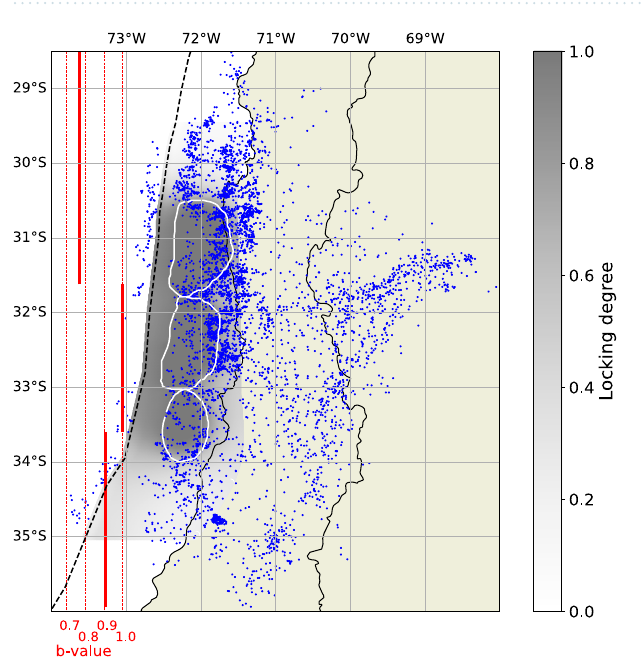
Figure 5. The figures show the Gutenberg–Richter law representation of the obtained b-value for each segment. Upper figures represent the solutions along strike, and lower figures correspond to the results along dip. The blue star represents the number of events larger than a magnitude m , the orange line corresponds to the Gutenberg Richter law computed with the obtained b-value, and the red dotted line represents the chosen M c . ( a ), ( b ) and ( c ) correspond to the events from 0 to ∼ 33 km, from ∼ 33 to ∼ 70 km, and from ∼ 70 to ∼ 160 km depth, respectively. Subfigures ( d ), ( e ), and ( f ) correspond to the events between 35.94 ◦ to 33.59 ◦ S, 33.59 ◦ to 31.62 ◦ S and 31.62 ◦ to 28.5 ◦ S, respectively.